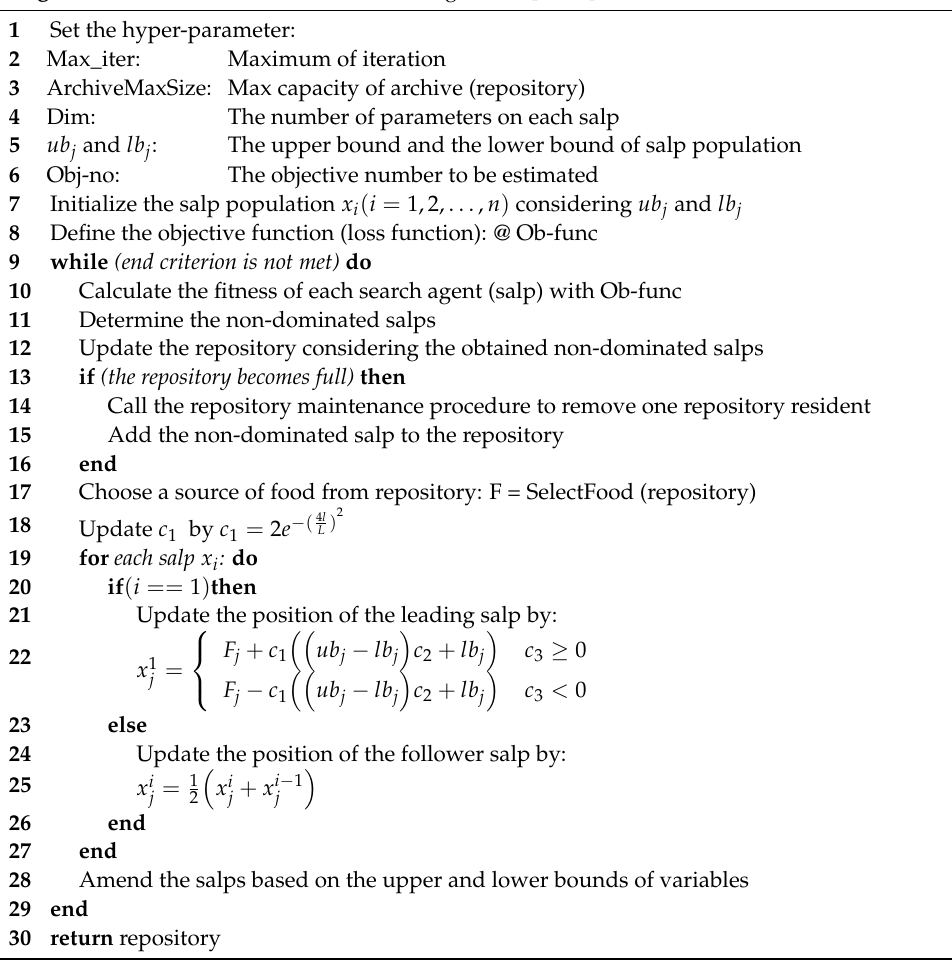
Algorithm 1. Pseudo code of the MOSSA algorithm